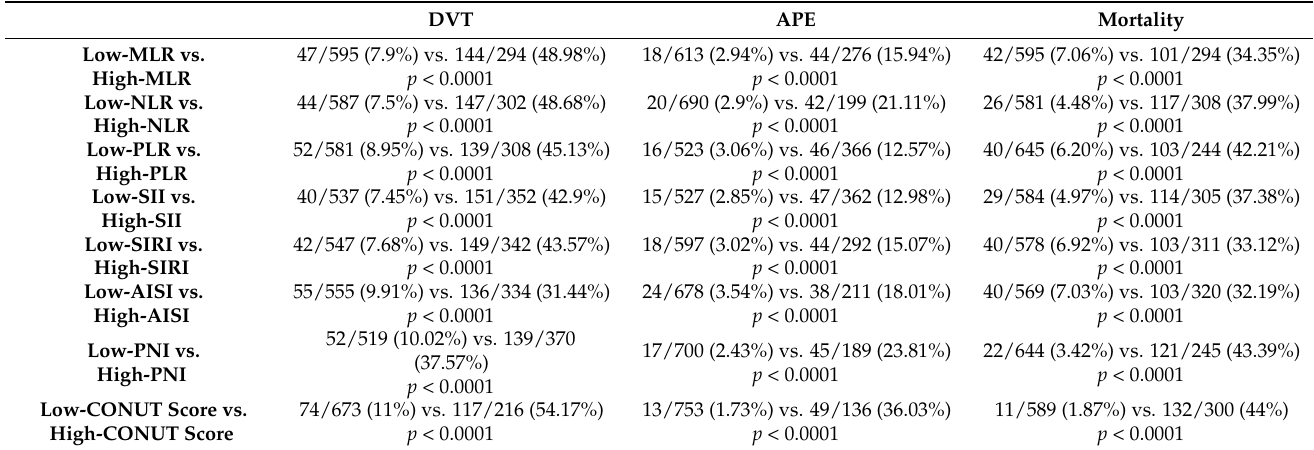
Table 4. Univariate analysis of inflammatory and nutritional markers and